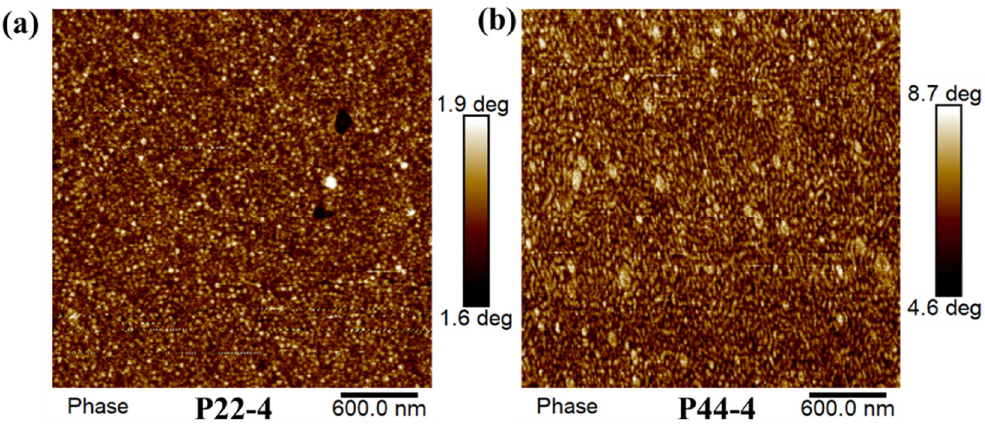
Figure 5. Atomic force microscopy (AFM) phase images (3 × 3 μm 2 ) of P22-4 ( a ) and P44-4 ( b ).